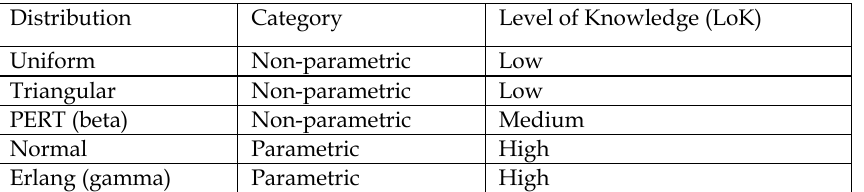
Table 1. Applied probability distributions within the assessment of transport projects (Salling